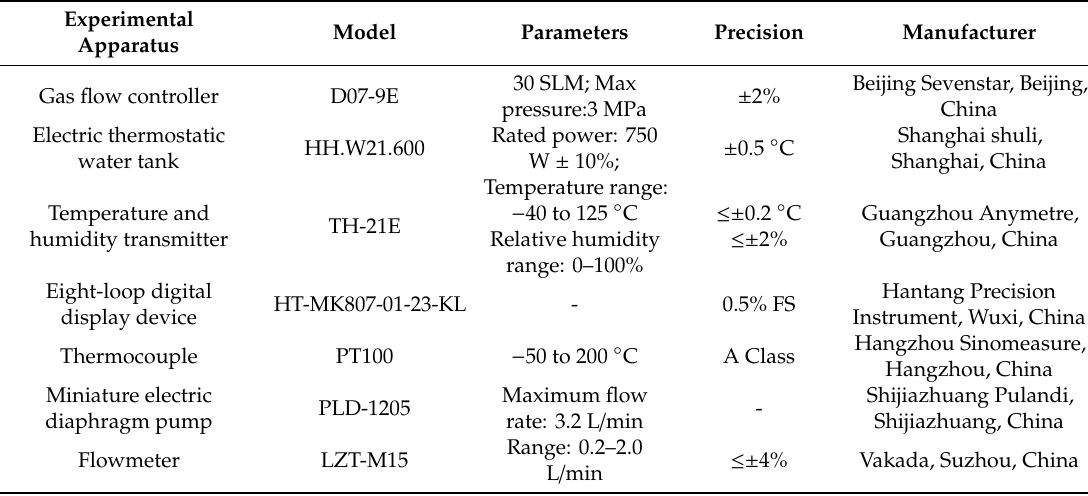
Table 2. Parameters of experimental